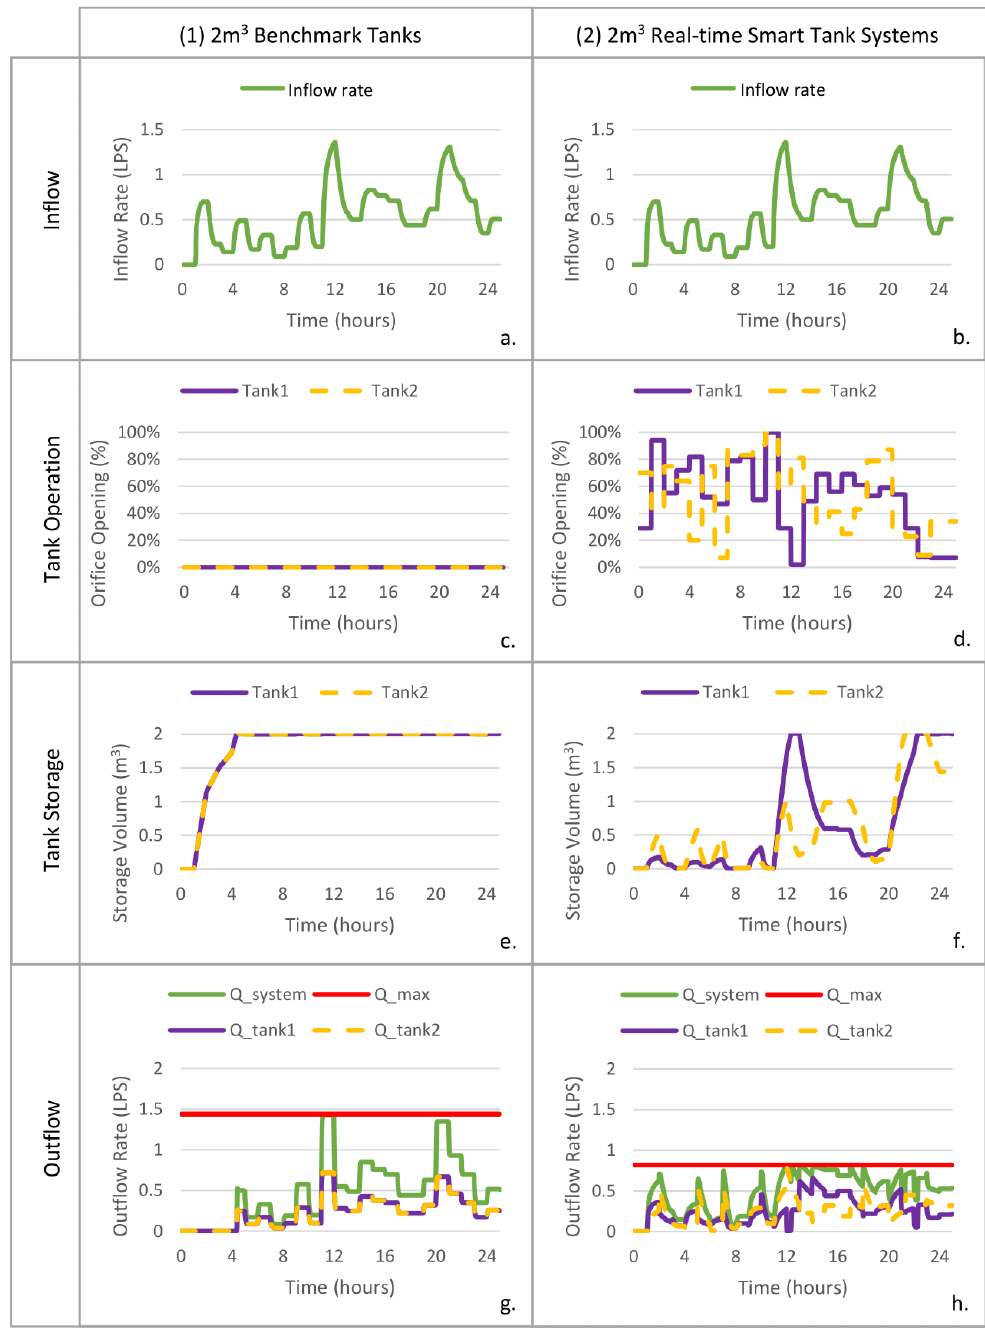
Figure 7. Typical operation rules for ( 2 ) 2 m 3 real-time smart tank systems compared to ( 1 ) 2 m 3 benchmark tanks (Adelaide, 24 h duration, 1%AEP). benchmark tanks (Adelaide, 24 h duration,